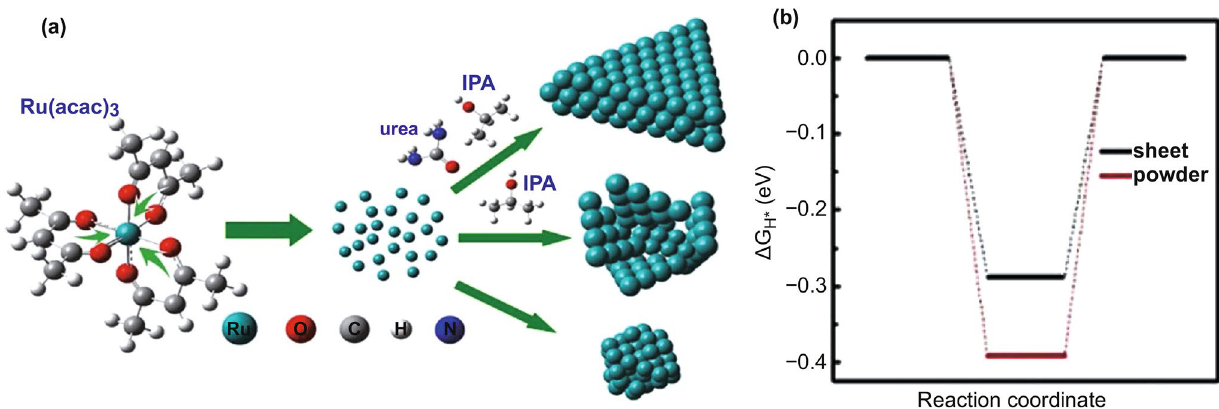
Fig. 7 a Schematic illustration of the growing process of Ru nanosheets. b ΔG H* value of Ru nanosheet and powder [88], with permission from the American Chemical Society